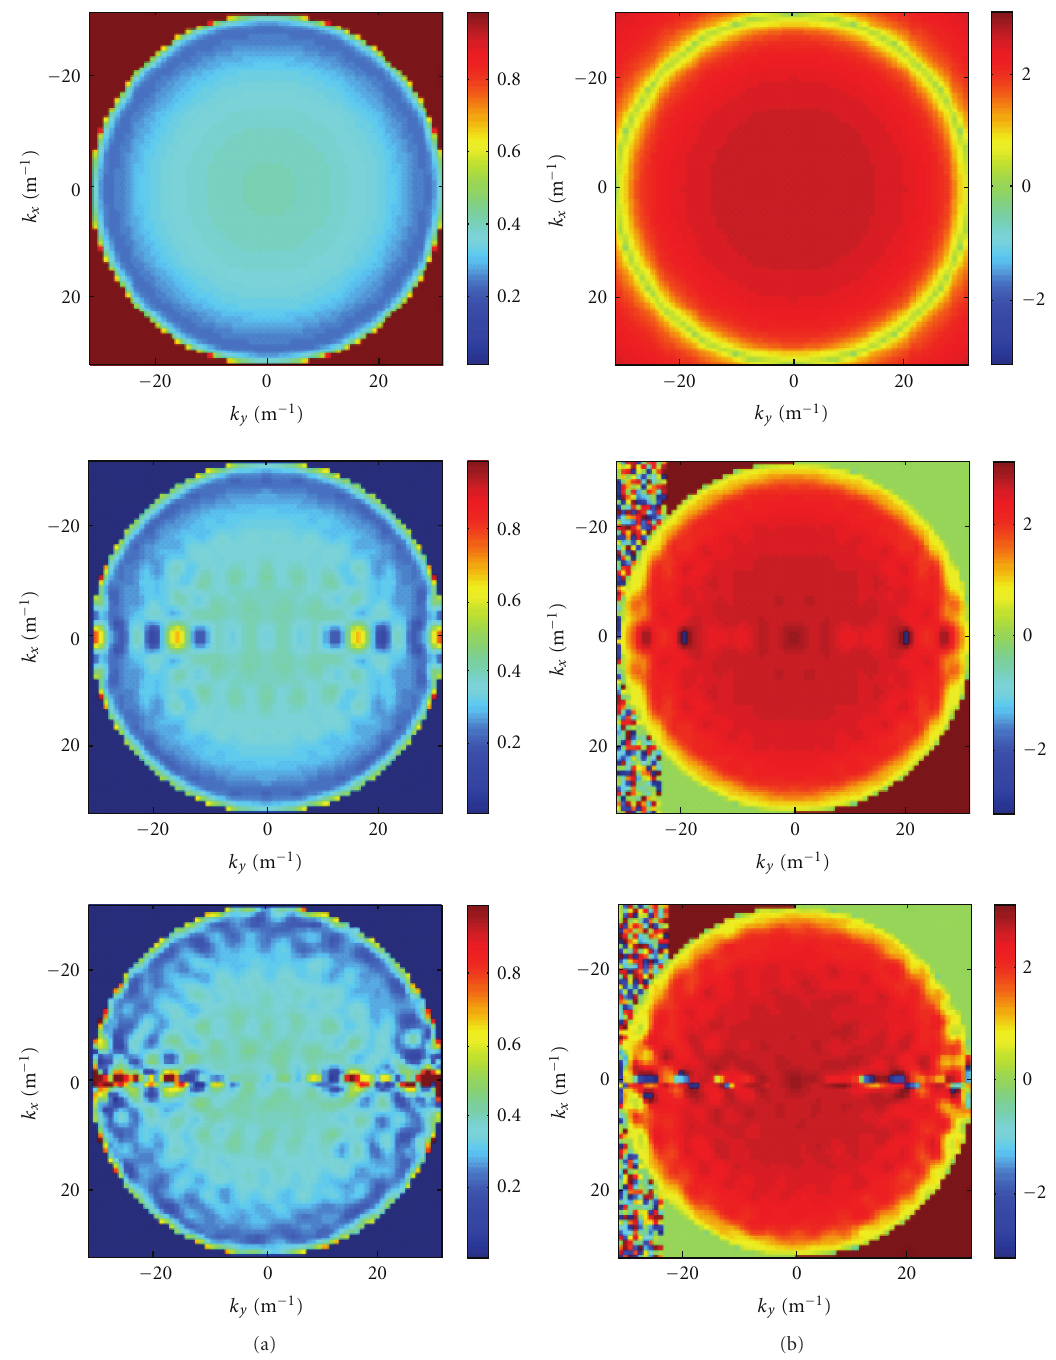
Figure 9: Soil 3. Amplitude (a) and phase (b) of Γ TM . Top line: actual values; middle line: noiseless estimation; bottom line: noisy